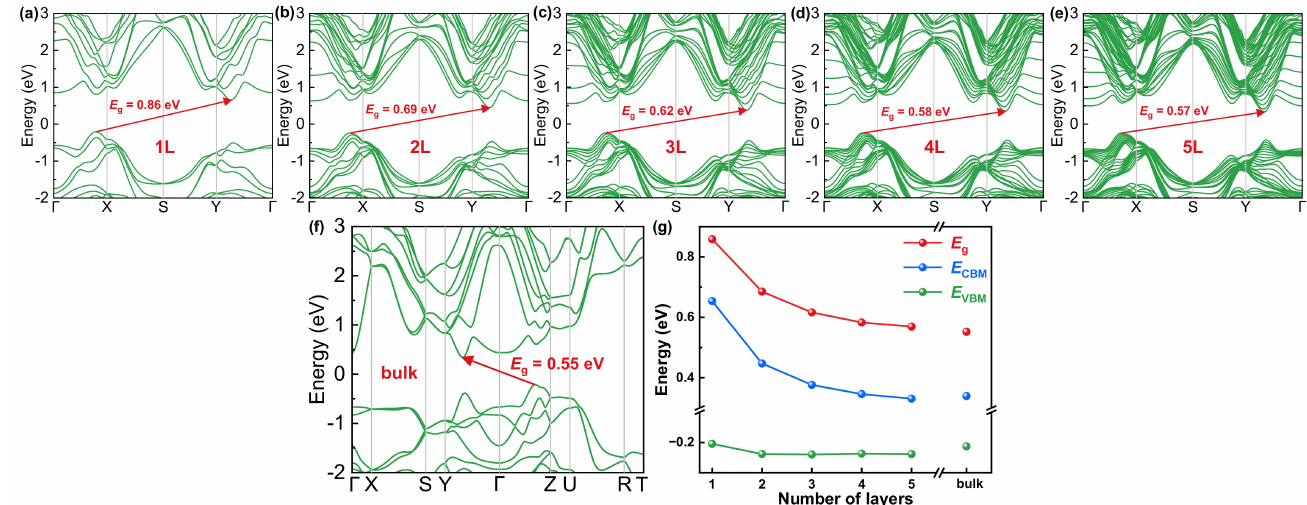
Figure A1. Band structure of 2D SnSe ( a – e ) from l layer to 5 layers (1 L–5 L) and ( f ) bulk SnSe calculated by first-principle, ( g ) bandgap energy E g , conduction band minimum (CBM) energy E CBM , and valence band maximum (VBM) energy E VBM varied with the number of